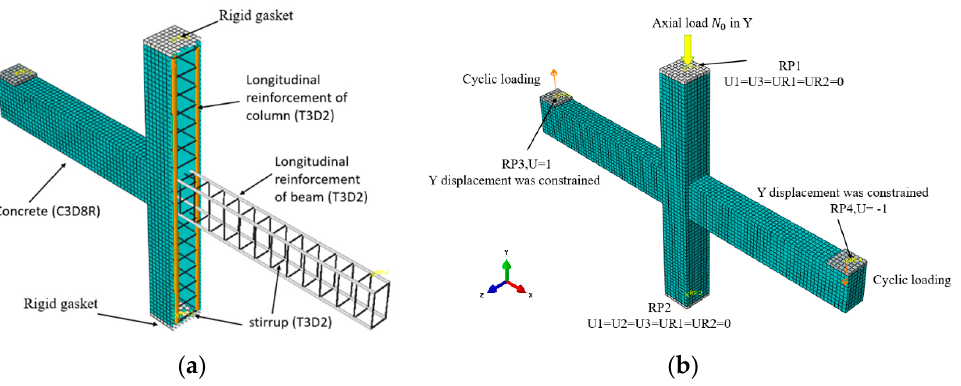
Figure 3. ( a ) Unit type; ( b ) boundary condition and loading of the FE